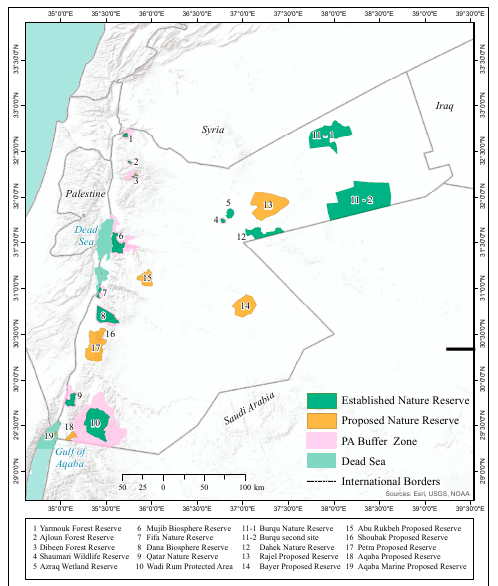
Figure 1. Current status of the national network of protected areas in Jordan.